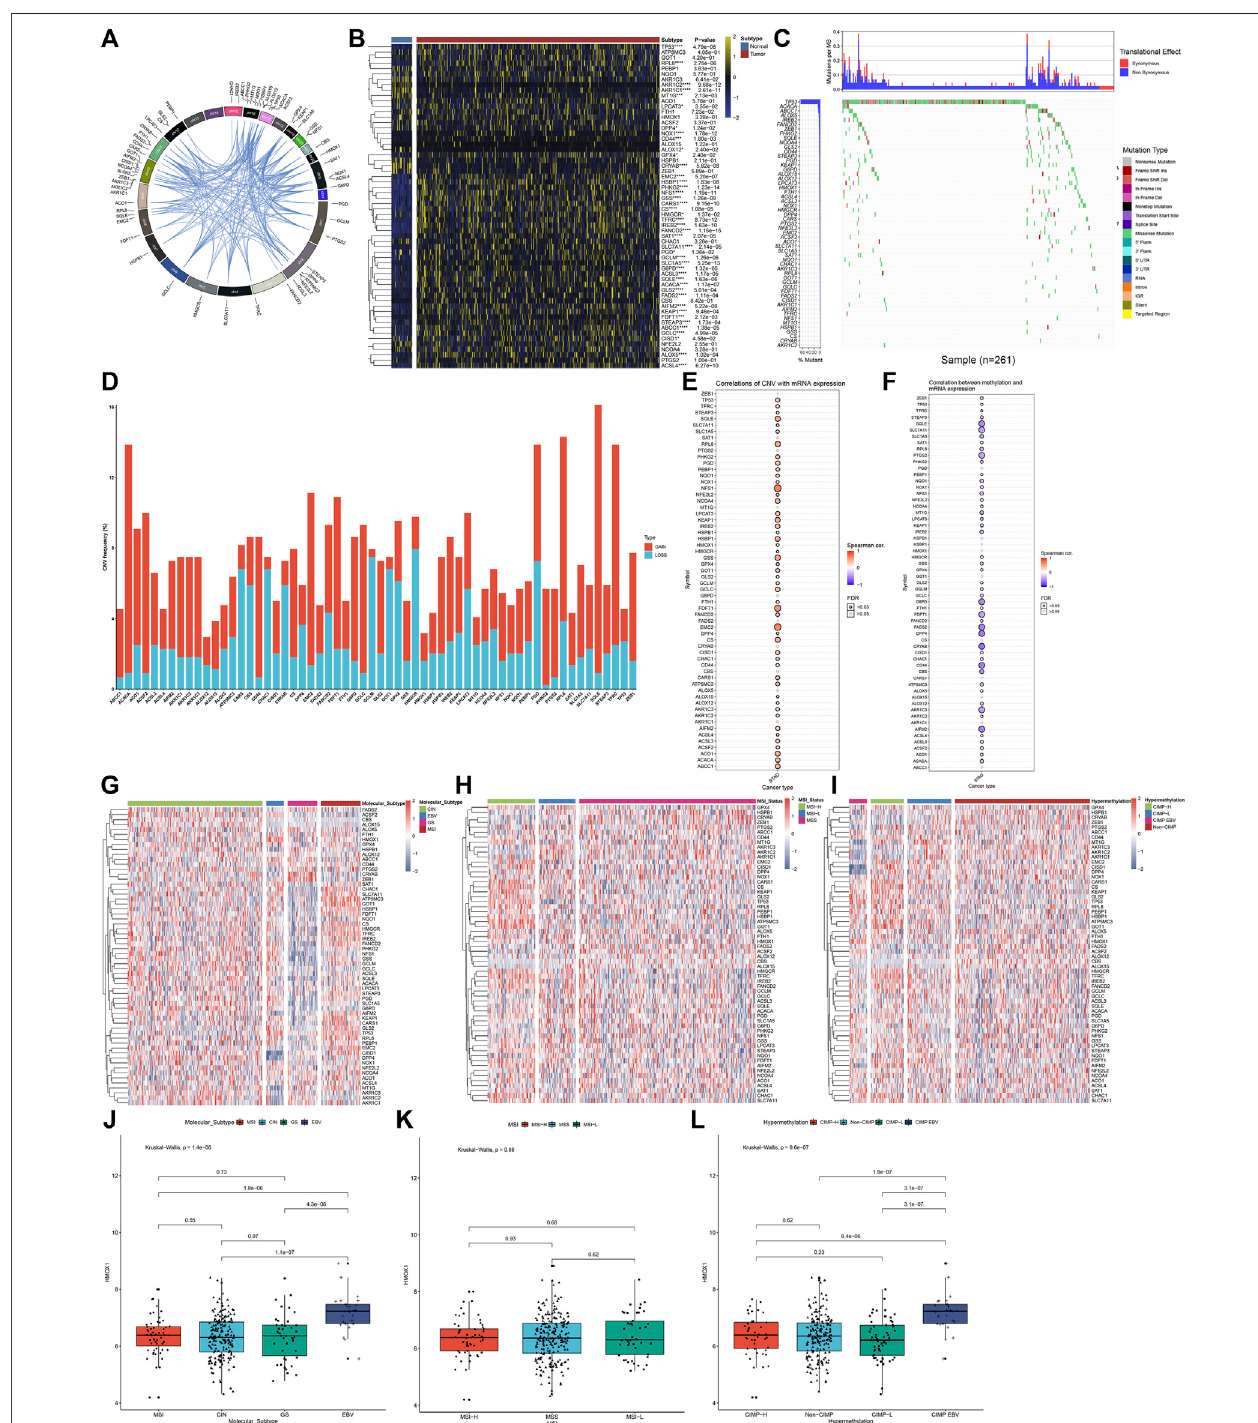
FIGURE1| Landscape ofexpression,geneticmutation,and DNAmethylationofferroptosis regulators inGC. (A) RCircos plotsshowingthegenomiclocationand relationships among 60 ferroptosis regulators. (B) Heatmap visualizing the mRNA expression of ferroptosis regulators in 32 normal and 375 GC tissues in the TCGA- STADdataset.Yellow,upregulation;blue,downregulation.* p < 0.05;*** p < 0.001;**** p < 0.0001. (C) Waterfalldiagramforthegeneticmutationofferroptosisregulators across 261 GC specimens. The left indicated the mutation rate of each ferroptosis regulator. Each column represented each sample. Each mutation type was identi fi ed by a unique color. The upper indicated mutations per MB in each ferroptosis regulator. (D) Stacked diagram visualizing the frequency of CNV across GC specimens.Red,ampli fi cation; blue,deletion. (E)